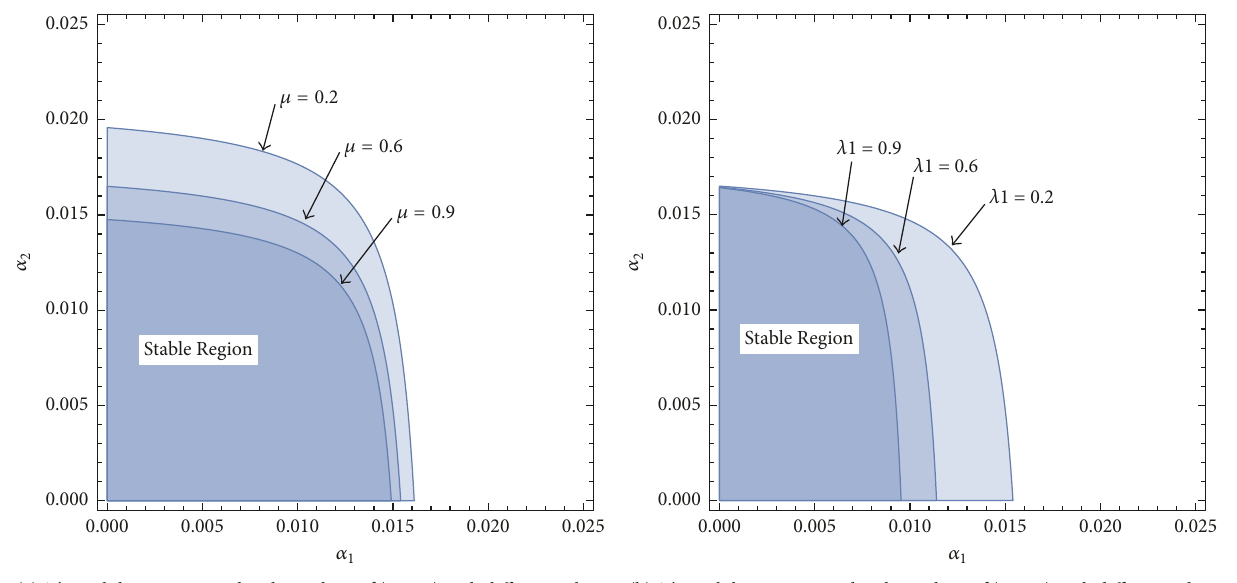
(b) The stability regions in the phase plane of (𝛼 1 ,𝛼 2 ) with different values of 𝜆 1